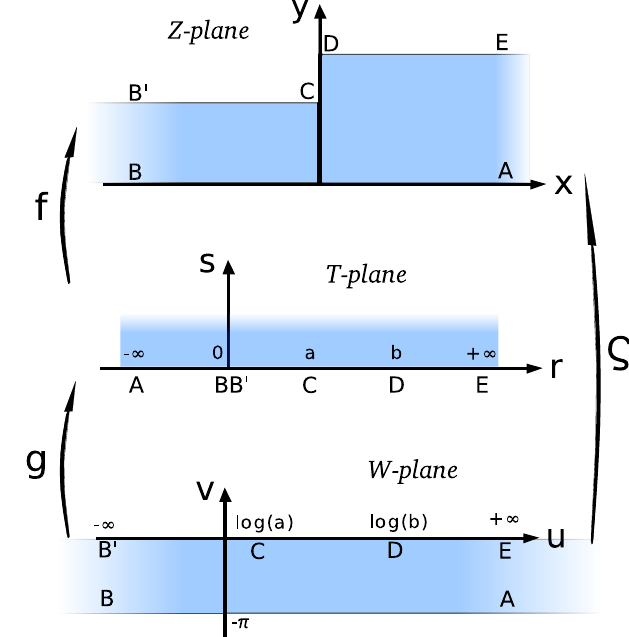
FIG. 3. A section of one side of the trap: the crosshatched areas are the electrodes, the continuous lines are the equipotentials, the FIG. 4. The three working planes. The Z plane is the physical domain A is surrounded by a dashed border, and the circled plane corresponding to domain A in Fig. 3. The T plane is an points, which define our boundary points represent the z intermediate step due to the fact that the Schwarz-Christoffel i method always maps a polygon on the upper complex plane where Im ð t Þ ¼ s > 0 . The W plane is the calculation plane where we can apply the method of Sec. II since it can be seen as the section of a constant radius cylinder. The arrows on the border represent the three mapping used to transform one plane to the other.